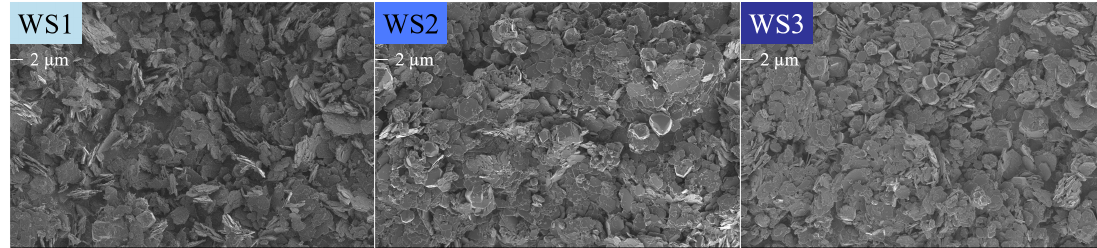
Figure 23. SEM micrographs of the water-to-solids ratio series WS1 = 70:30, WS2 = 80:20 and WS3 = 90:10 taken at 1keV and 2k magnification. The scale bar is indicated below the label.